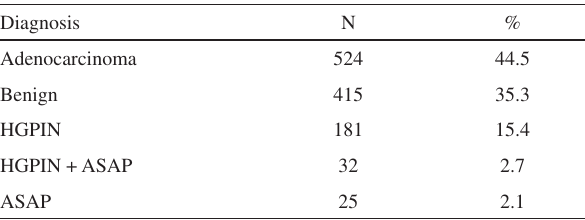
Table 1 ­ Results of 1177 biopsies examined between July